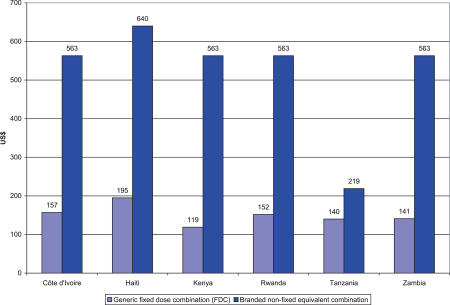
Annual Treatment Cost of Stavudine 40 mg + Lamivudine 150 mg + Nevirapine 200 mg per Patient in Countries Receiving PEPFAR Funding for which Cost Information Is AvailableSource: Global Price Reporting Mechanism, http://www.who.int/3by5/amds/price/hdd/index.aspx Note: These calculations have been made with the most recent cost published. Drug manufacturers include Cipla (FDC), Bristol-Myers Squibb (stavudine), GlaxoSmithKline (lamivudine), and Boehringer Ingelheim (nevirapine). In all these countries, the annual cost of branded stavudine is US$55 and that of branded lamivudine is US$70; nevirapine accounts for the rest of the cost.